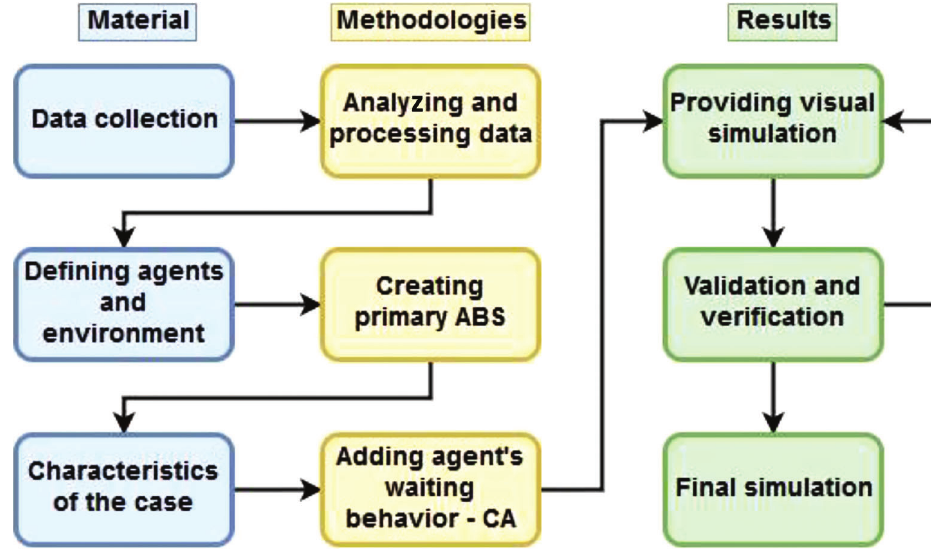
Figure 1. Simulation framework. ABS: agent based simulation; CA: cellular